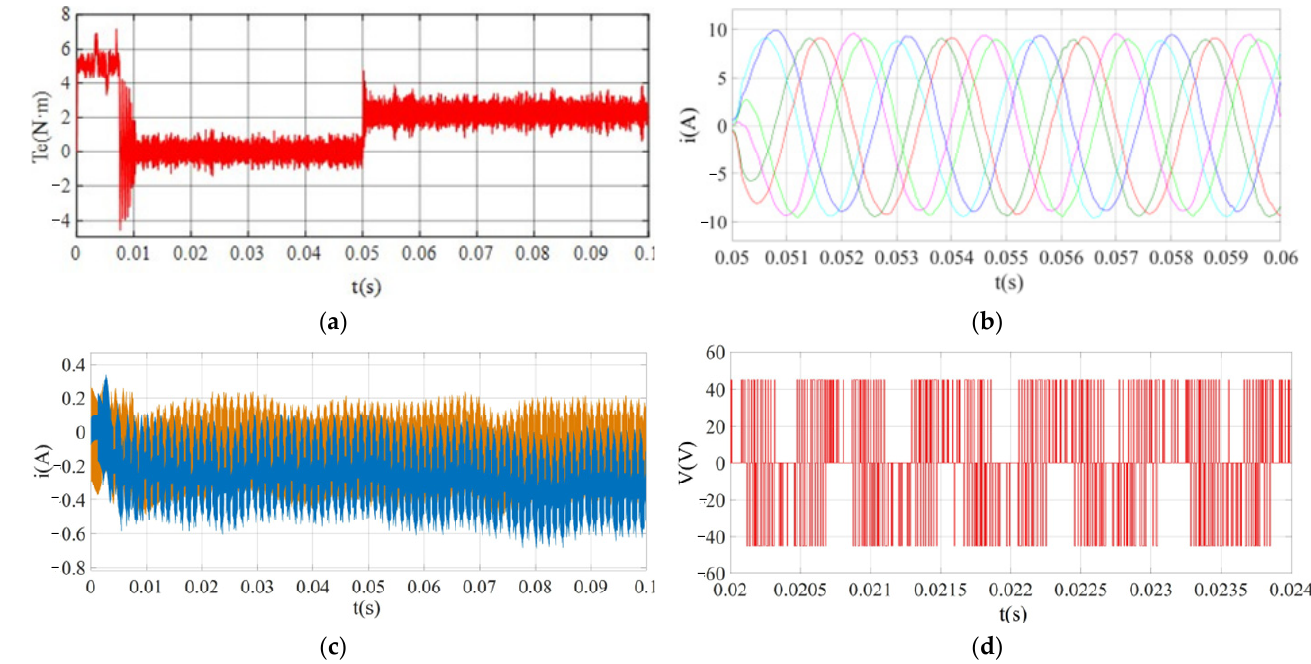
Figure 10. Output performance of MPTC1: ( a ) output torque; ( b ) six-phase stator current; ( c ) harmonic current components in x-y subplace; ( d ) common-mode voltage.